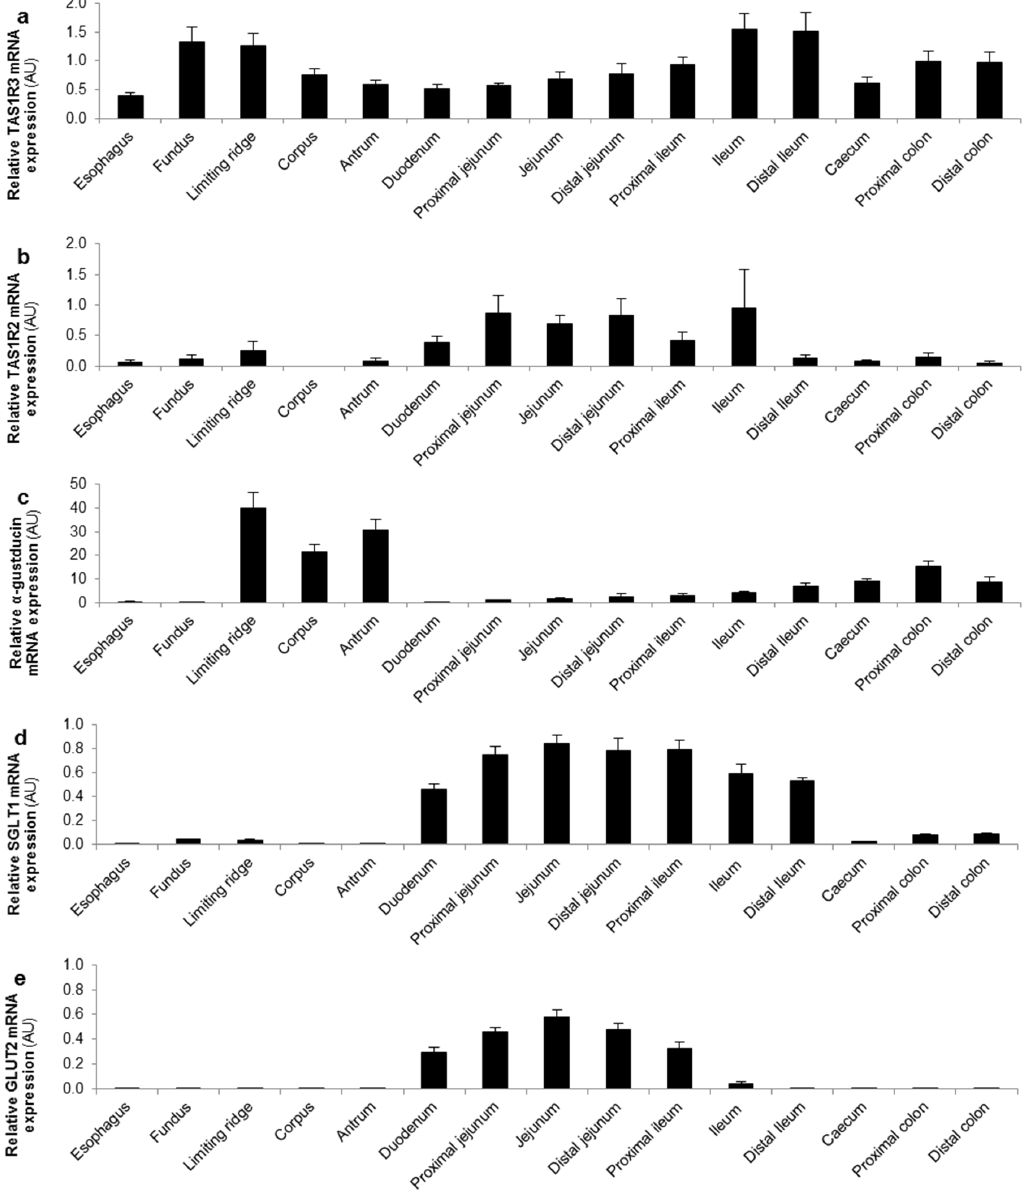
Figure 3. TAS1R3 and α -gustducin are expressed throughout the gastro-intestinal (GI) tract while TAS1R2 and the glucose transporters are expressed in the small intestine. Relative mRNA expression levels of ( a , b ) the two subunits of the sweet taste receptor (TAS1R2-TAS1R3); ( c ) α -gustducin and ( d , e ) the glucose (SGLT-1, GLUT2) transporters throughout the mouse GI tract ( n = 5). Results are presented as mean ± SEM. AU: arbitrary units.